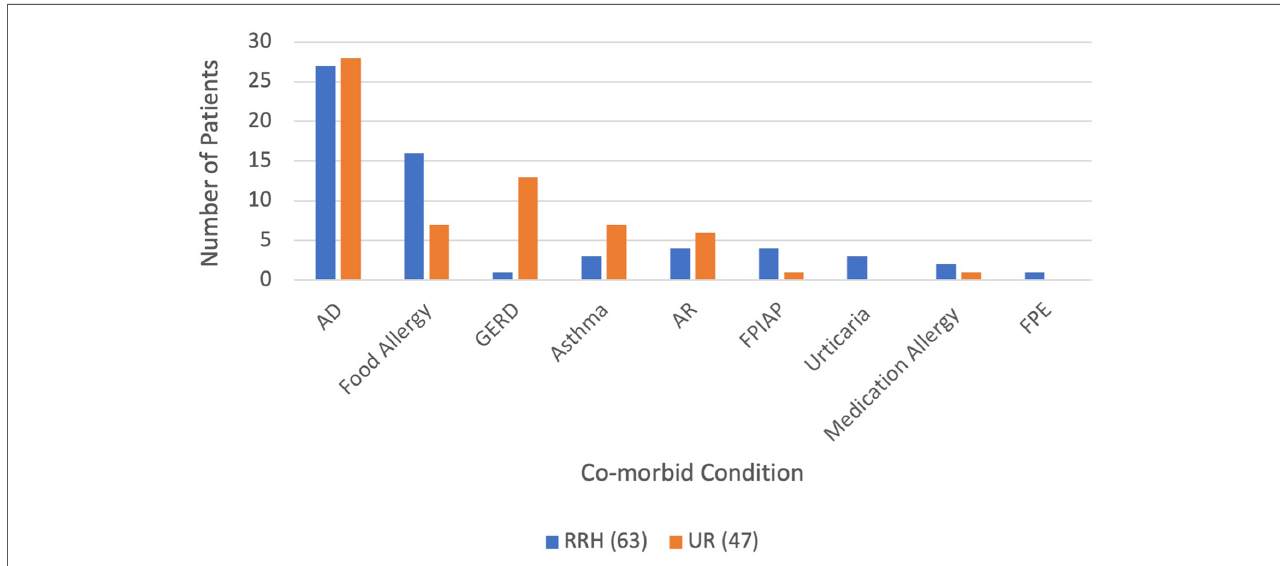
FIGURE 4 Atopic and gastrointestinal co-morbid conditions among cohorts. AD: atopic dermatitis, Food allergy: IgE-mediated food allergy, GERD: gastrointestinal re fl ux disease, AR: allergic rhinitis, FPIAP: food protein-induced allergic proctocolitis, FPE: food protein-induced